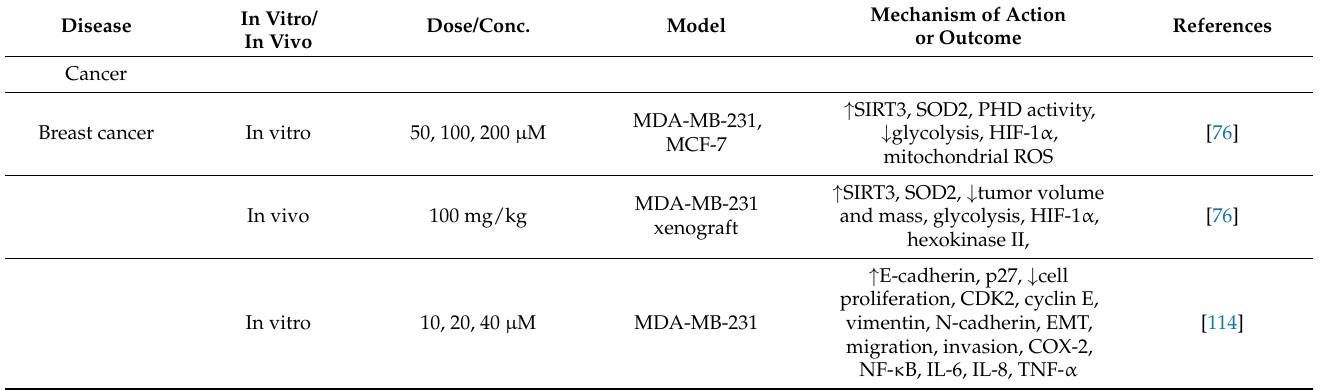
Table 1. Preventive and therapeutic properties of OA against various chronic diseases. Disease In Vitro/ In Vivo